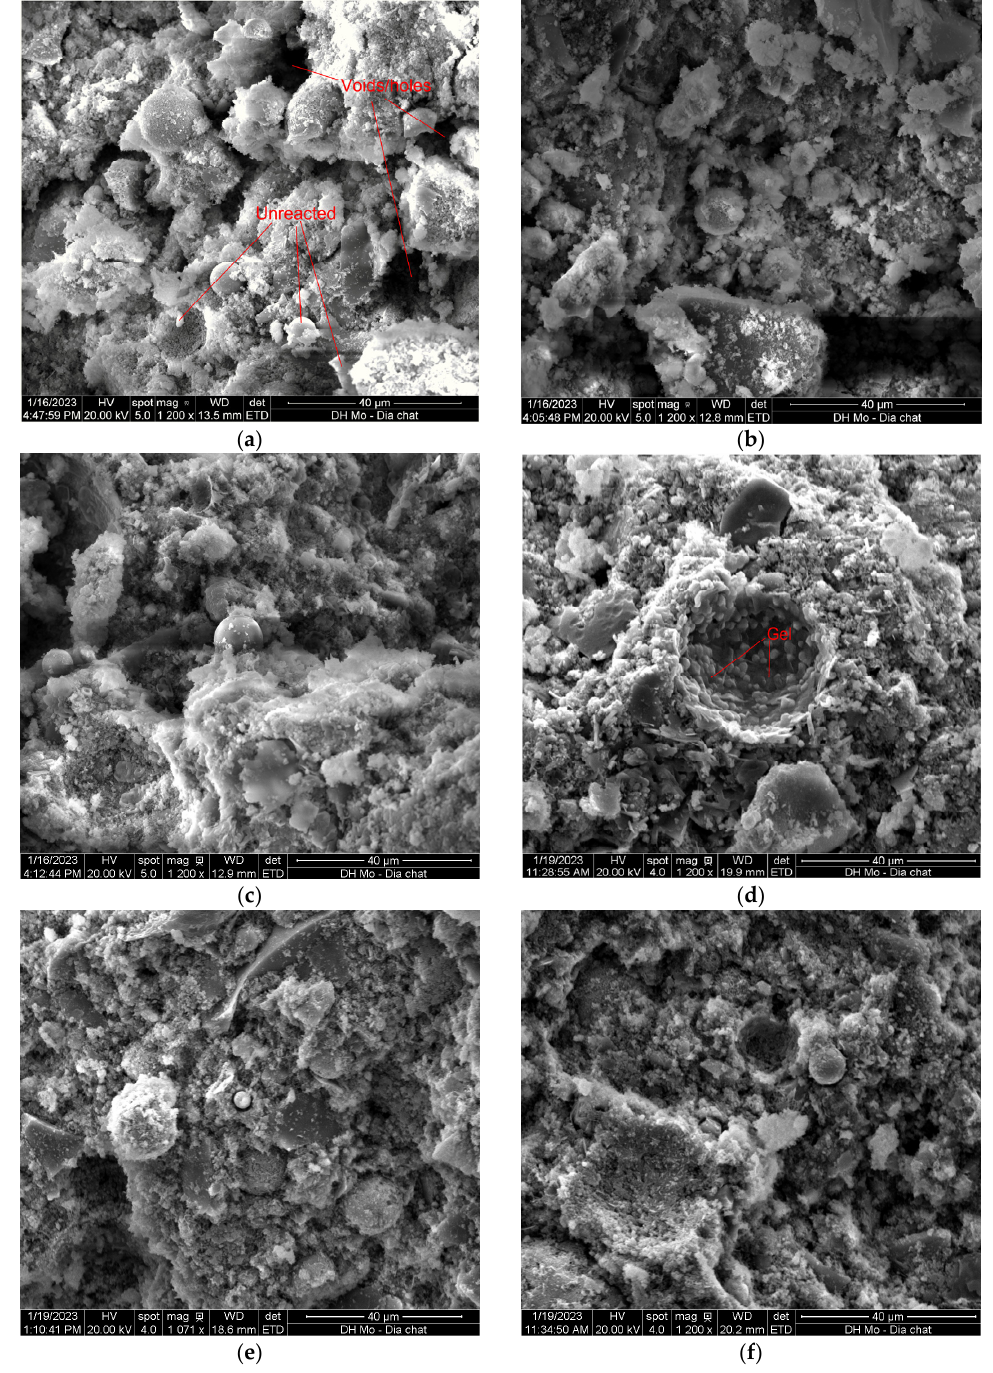
Figure 5. Scanning electron micrographs of geopolymer materials prepared using 8 M NaOH activator and Ca(OH) 2 content of 0 g ( a ), 15 g ( b ), 30 g ( c ), 45 g ( d ), 60 g ( e ), 75 g ( f ) at 28 days of curing time.